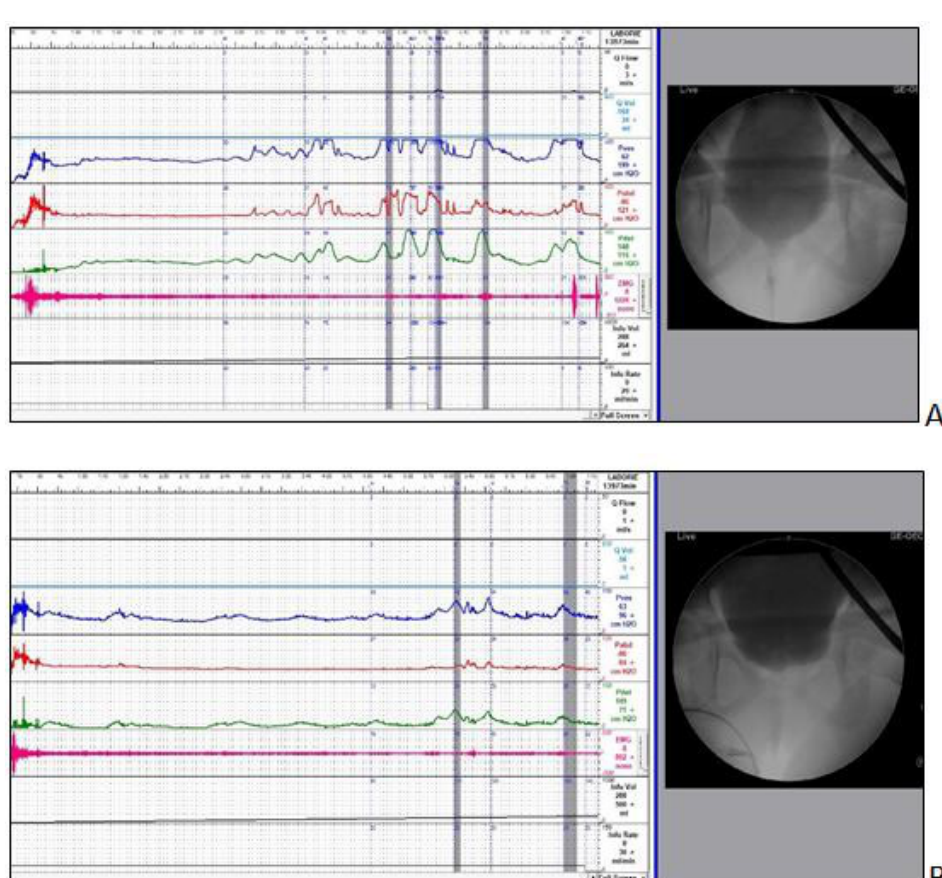
Figure 2. Video urodynamic tracings of a female with dysfunctional voiding and recurrent urinary tract infection. ( A ) Video urodynamic study at baseline shows detrusor overactivity with high voiding pressure and tight urethral sphincter during voiding. ( B ) One year after antimuscarinic treatment, the detrusor overactivity is decreased in frequency and amplitude and the bladder capacity increased, resulting in urinary incontinence improvement. Q, flow rate; Qvol, voided volume; Pve, intravesical pressure; Pabd, intra-abdominal pressure; Pdet, detrusor pressure; EMG, electromyogram of external